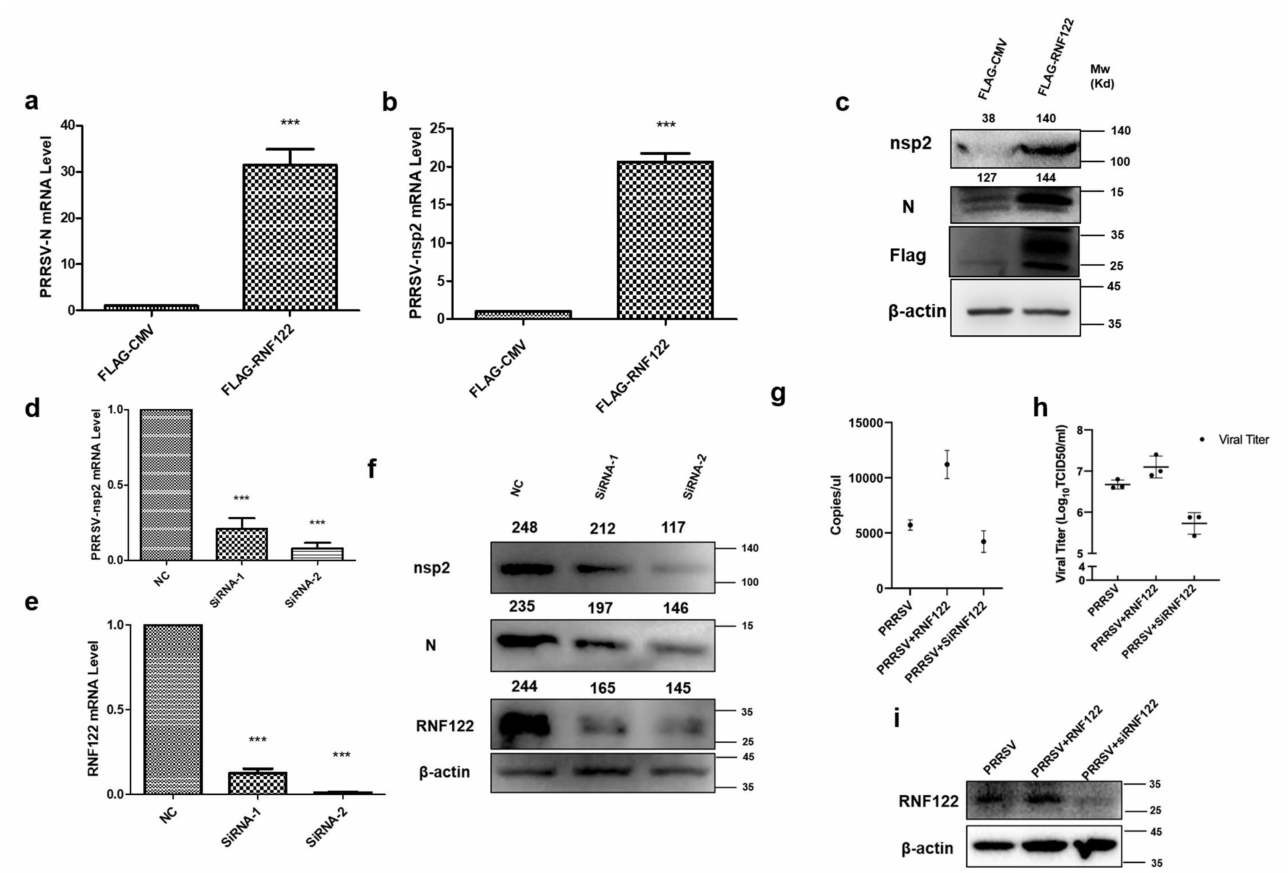
Figure 5. Porcine RNF122 promoted viral replication of PRRSV. ( a , b ) 3D4/21 cells were transfected with Flag-CMV or Flag-RNF122, 12 h later, cells were infected with PRRSV (MOI = 0.5). mRNA loads of PRRSV N and nsp2 were tested 12 h later by qRT-PCR. ( c ) 3D4/21 cells were transfected with Flag-CMV or Flag-RNF122, 12 h later, cells were infected with PRRSV (MOI = 0.5). PRRSV nsp2 were 12 h later tested by WB. ( d , e ) 3D4/21 cells were transfected with SiRNA or not; 12 h later, cells were infected with PRRSV (MOI = 0.5). mRNA loads of PRRSV nsp2 and RNF122 were tested 12 h later by qRT-PCR. ( f ) 3D4/21 cells were transfected with SiRNA or not; 12 h later, cells were infected with PRRSV (MOI = 0.5). PRRSV nsp2 was tested 12 h later by WB. ( g ) 3D4/21 cells were transfected with RNF122 or SiRNA; 12 h later, cells were infected with PRRSV (MOI = 0.5). PRRSV-N genes as an indicator to represent virus copy number and viral copies of PRRSV were tested 12 h later by qRT-PCR. ( h ) 3D4/21 cells were transfected with RNF122 or SiRNA; 12 h later, cells were infected with PRRSV (MOI = 0.5). TCID50 was calculated 48 h later by Reed Muench method. ( i ) 3D4/21 cells were transfected with RNF122 or SiRNA; 12 h later, cells were infected with PRRSV (MOI = 0.5). RNF122 was checked 12 h later by WB. *** p < 0.001 (analysis of two-way ANOVA attended by Bonferroni post-test). Data are representative of three independent